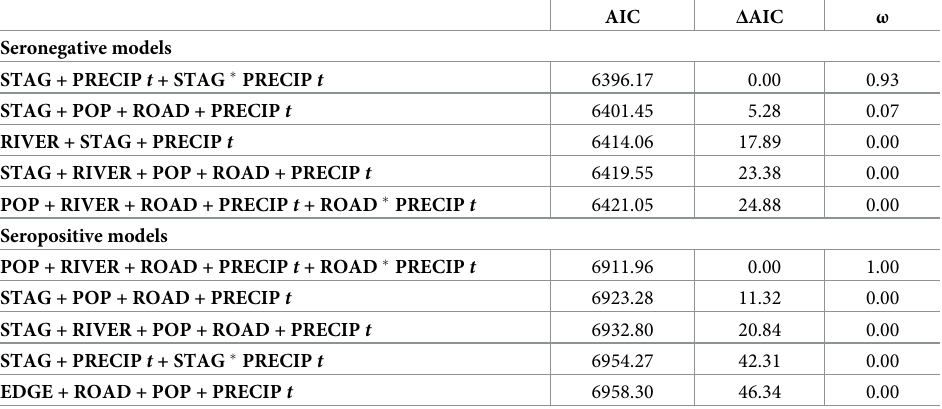
Table 3. The top five models describing resource selection of deer seronegative and seropositive for Jamestown Canyon virus in Des Plaines and Palos forest preserves of Cook County Illinois, 1996–1999.